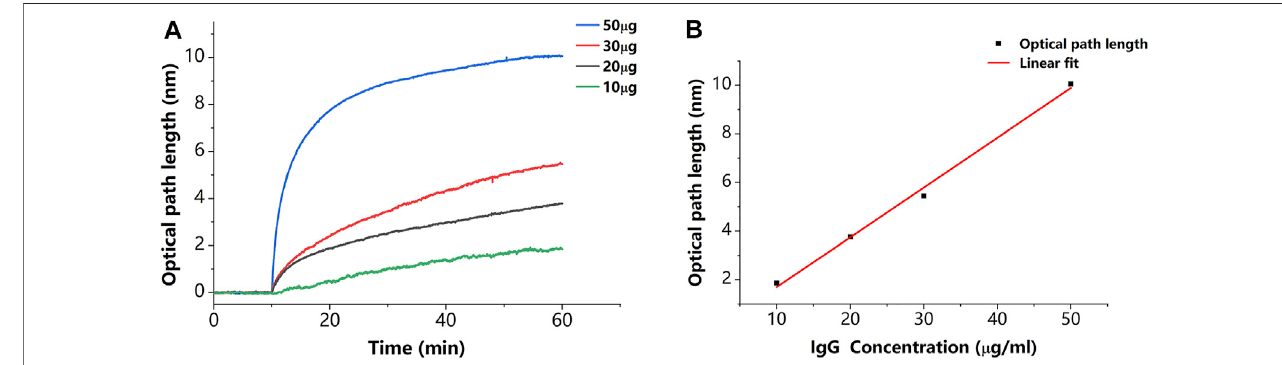
FIGURE 8| (A) Results ofbinding ofIgG to protein Ain different concentrations. (B) Relationship between thickness variation and IgG concentration. Each plotted data point in Figure 8B is averaged from three measurements.